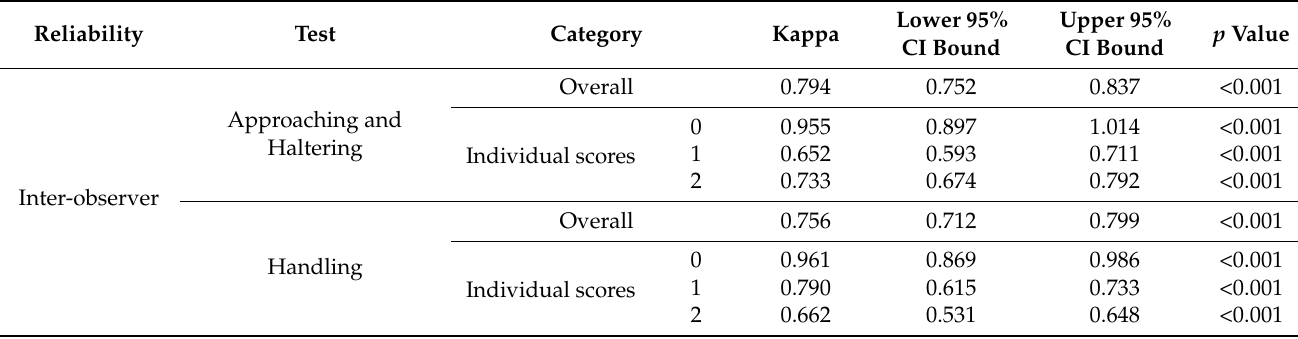
Table 3. Inter-observer reliability of scores for the four observers for the Approach and Haltering and Handling Tests (Fleiss’ kappa).